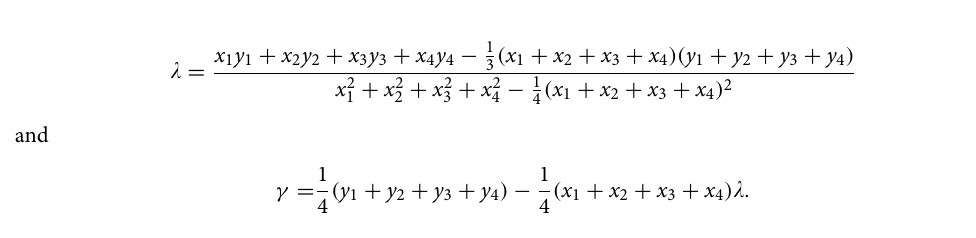
Figure 7. Shows a comparison of the linear least squares fit to experimental data and the linear model (8) for all alkanes of order